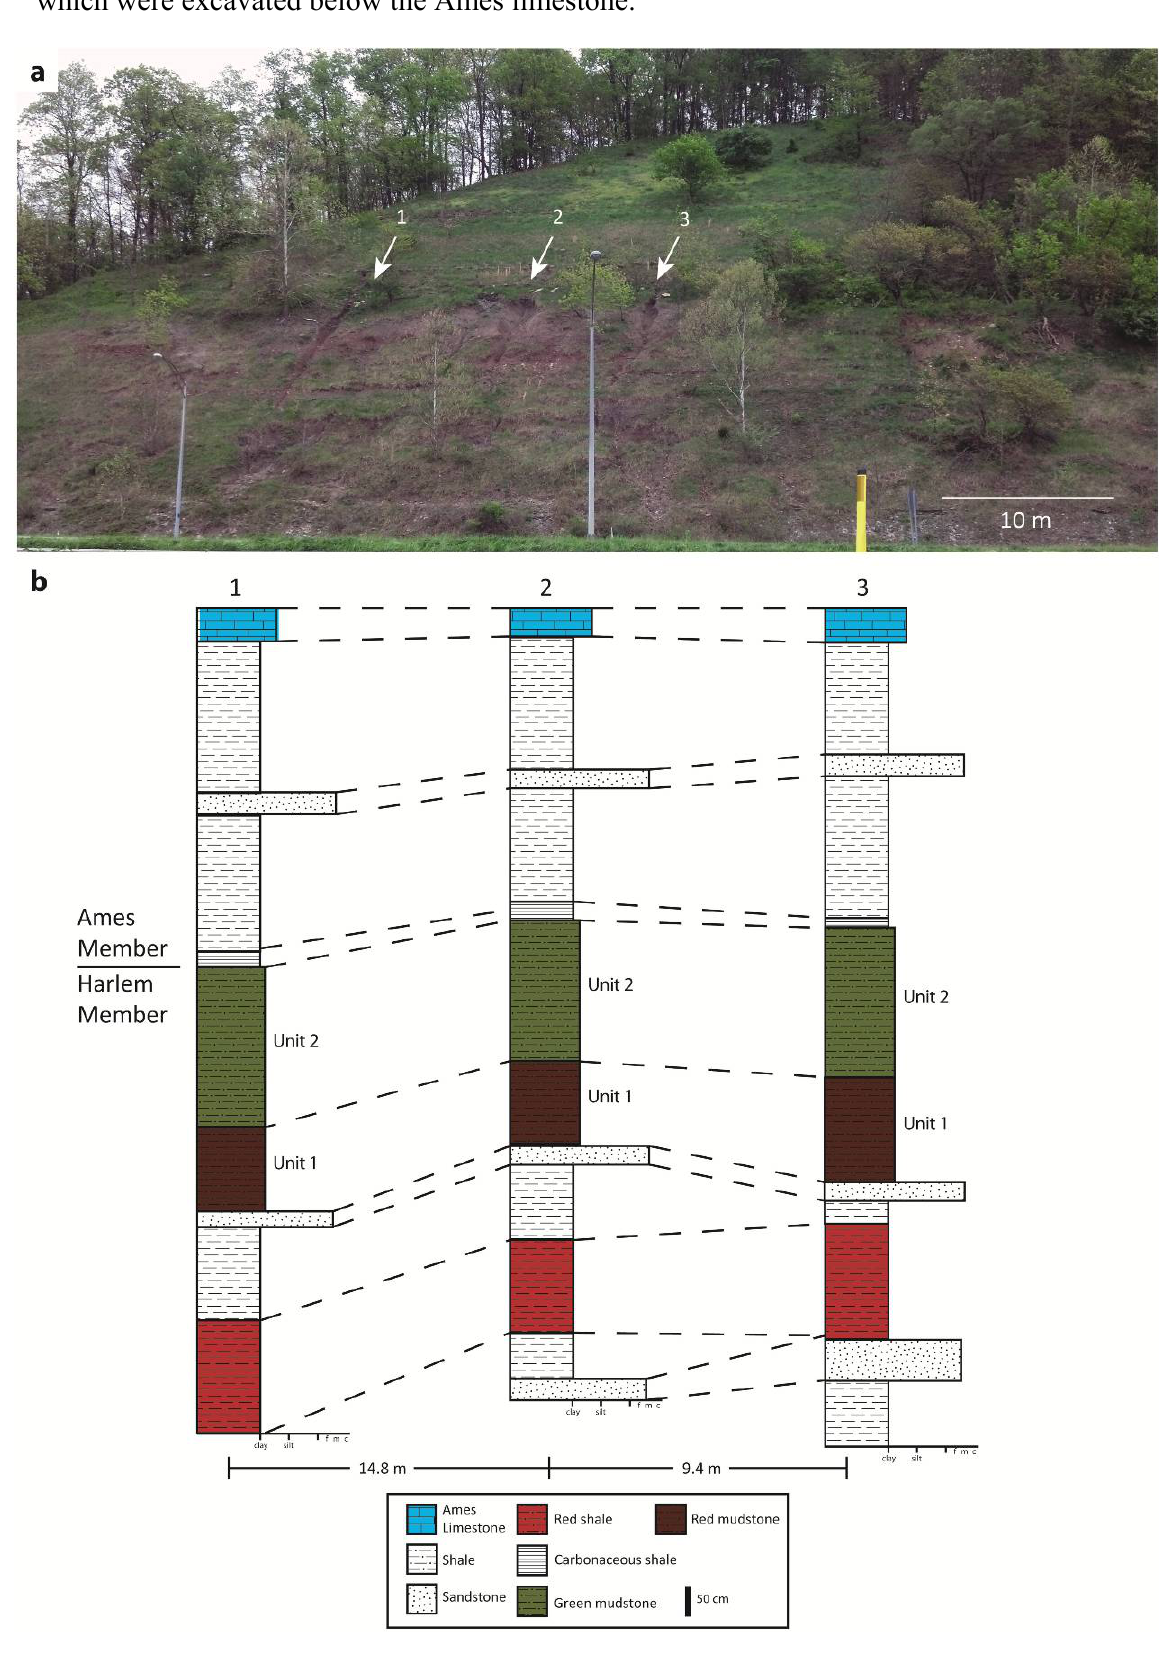
Figure 2. Field location and general stratigraphic columns of the three sections excavated. ( a ) Field location at Highway 33/Stimson Avenue exit in Athens County, OH, USA. The arrows point to the excavated sections; ( b ) General stratigraphic columns of the three section which were excavated below the Ames